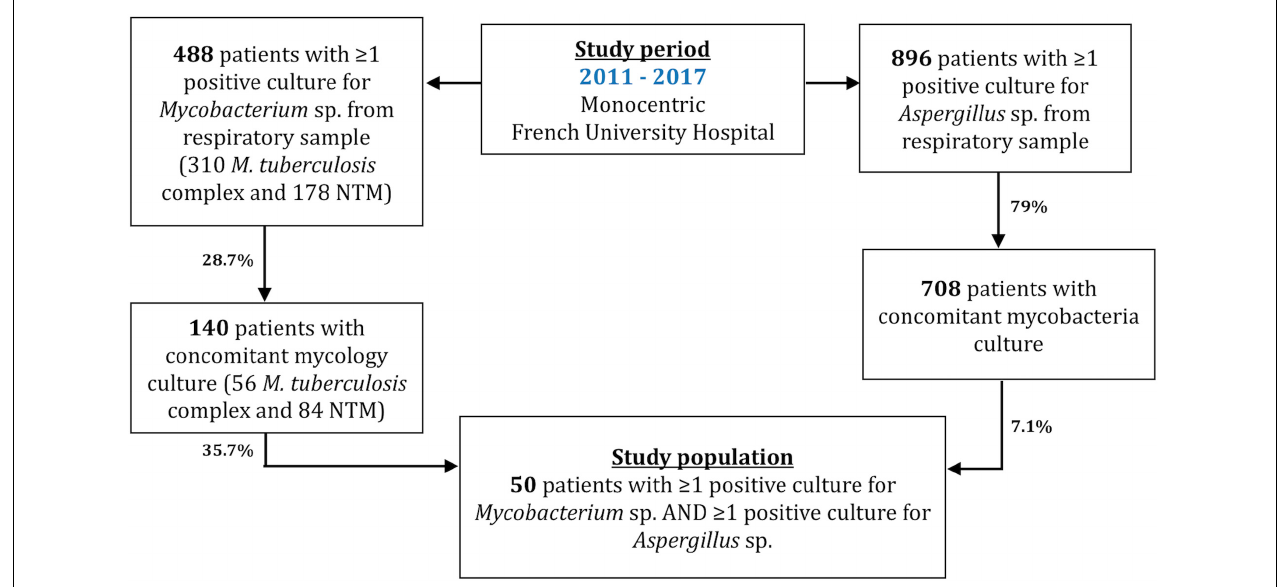
FIGURE 2 | Flow chart of the monocentric retrospective study conducted between January 2011 and December 2017. Patients were included with positive Aspergillus sp. and Mycobacterium culture from lower respiratory tract samples. Concomitant cultures define cultures performed on a respiratory sample within less than 3 months